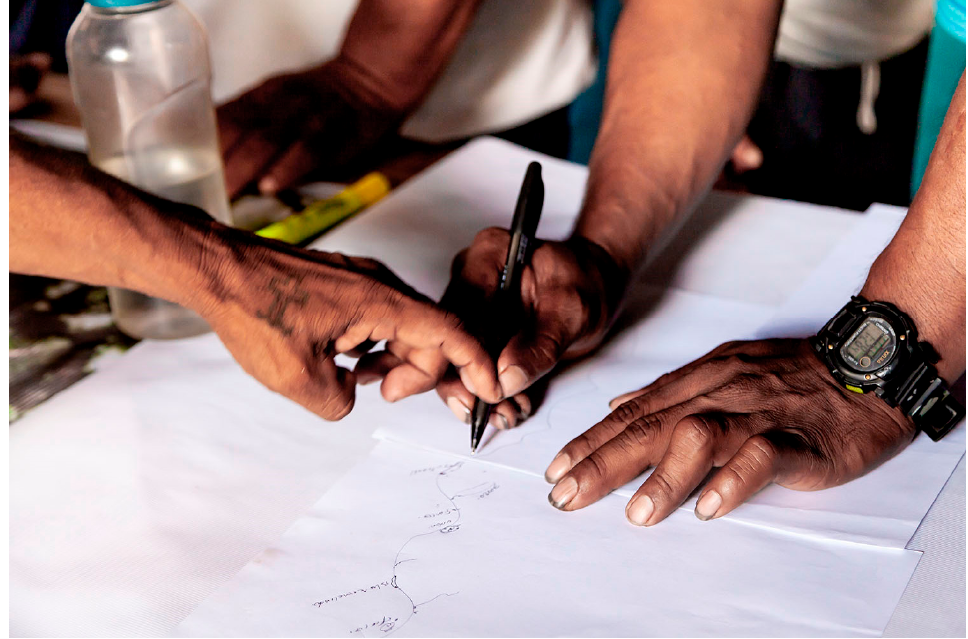
Figure 10. Drawing of the boundary perception (river) by Indigenous peoples. Cumaribo, 2020. Source: Land in Peace Project, Kadaster.